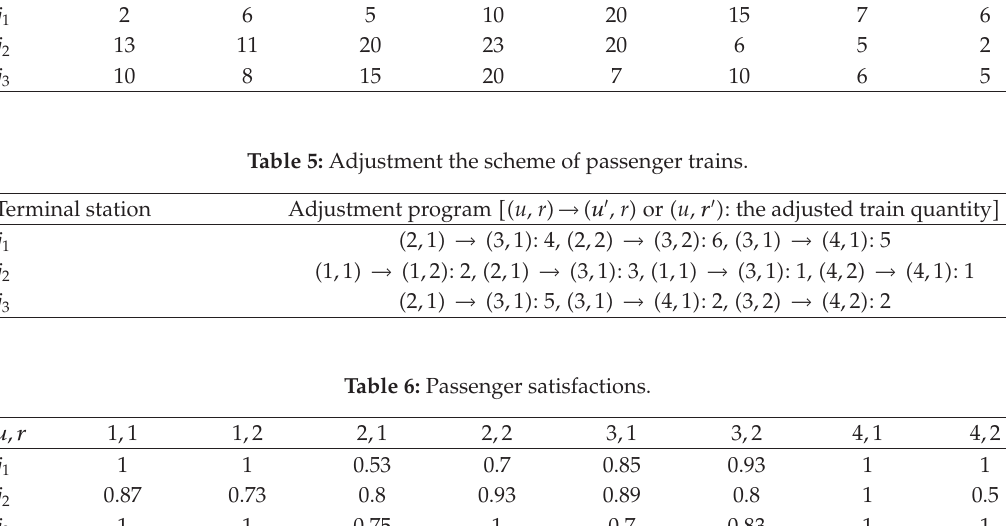
Table 4: Train operation quantity in every time-period n u,r